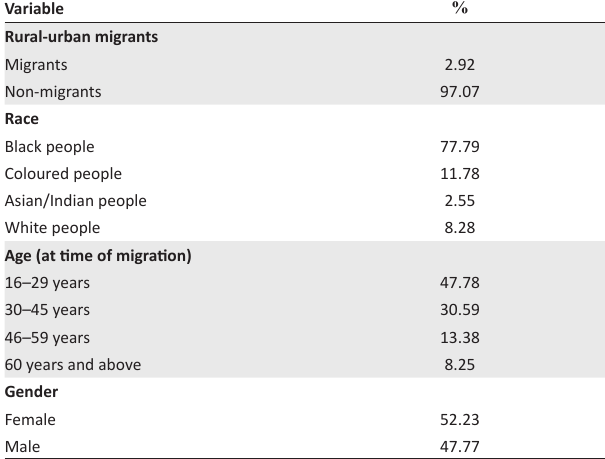
TABLE 2: Characteristics of migrants.